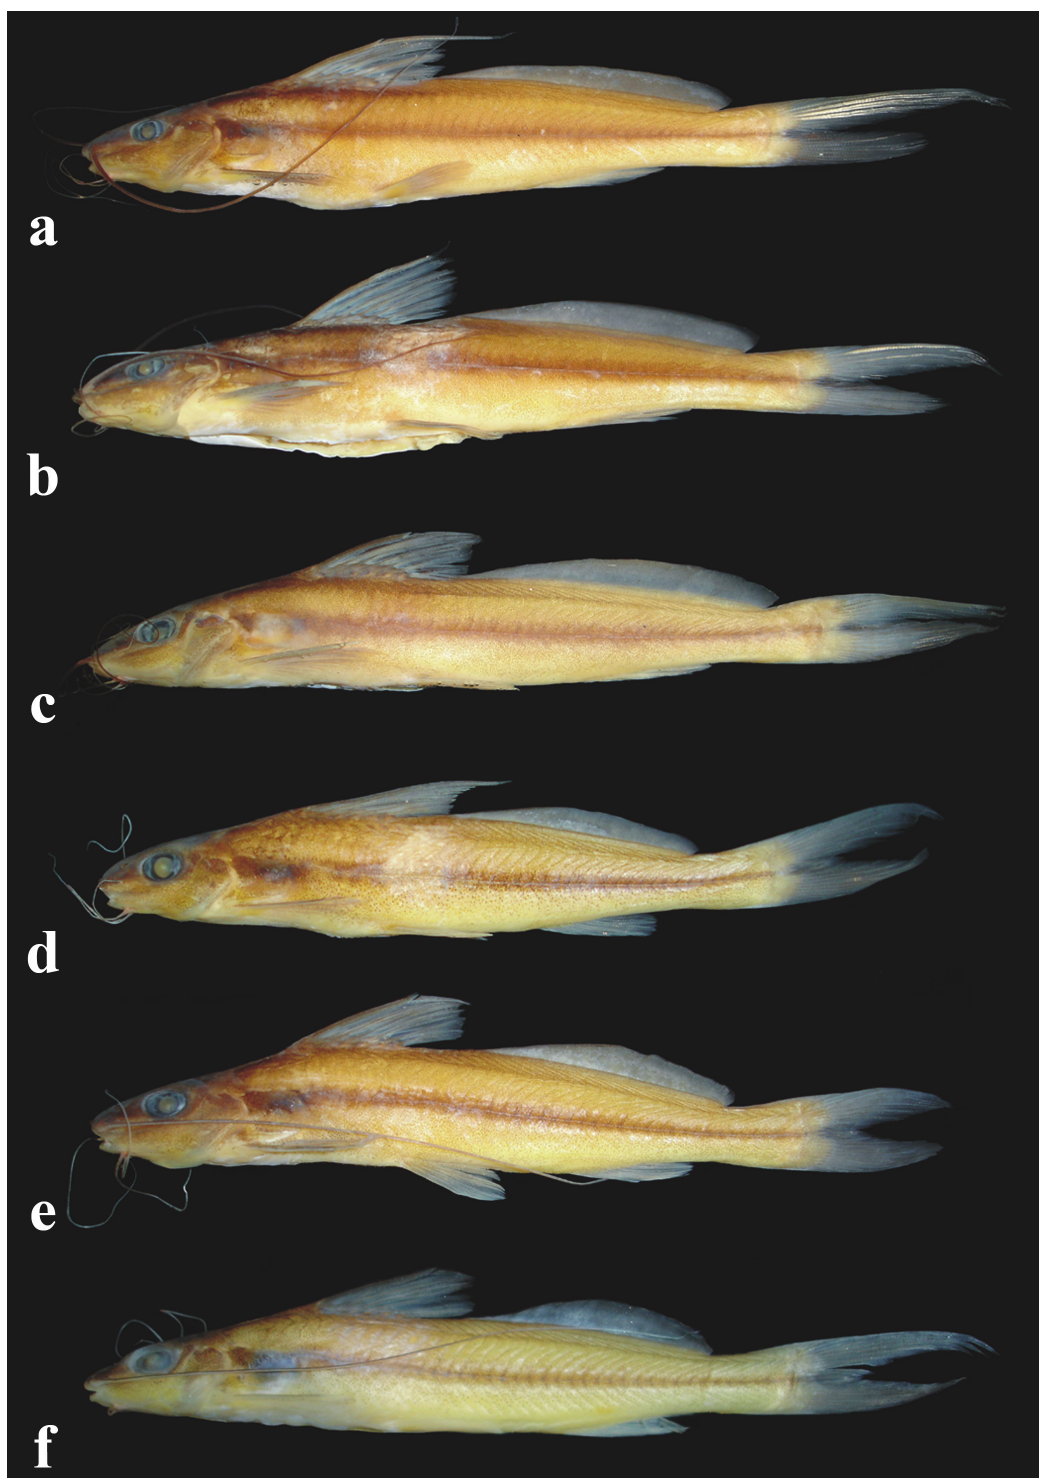
Fig. 6. a to c ) Pimelodella 2n = 52, from the Miranda River basin, Passo do Lontra, MS: a ) dorsal filament and upper lobe of caudal fin elongated (male, 123.6 mm SL), b ) dorsal fin filament slightly elongated and upper lobe of caudal fin elongated (male, 106.8 mm SL), c ) filament on dorsal fin absent and upper lobe of caudal fin not elongated (male, 117.6 mm SL). d to f ) Pimelodella 2n = 46 from the Miranda River basin, Passo do Lontra, MS: d ) filament on dorsal fin elongated and upper lobe of caudal fin slightly elongated (male, 82.7 mm SL), e ) Filament on the dorsal fin slightly elongated and upper lobe of caudal fin not elongated (female, 93.2 mm SL), f ) Filament on the dorsal fin absent and upper lobe of caudal fin elongated (female, 85.1 mm